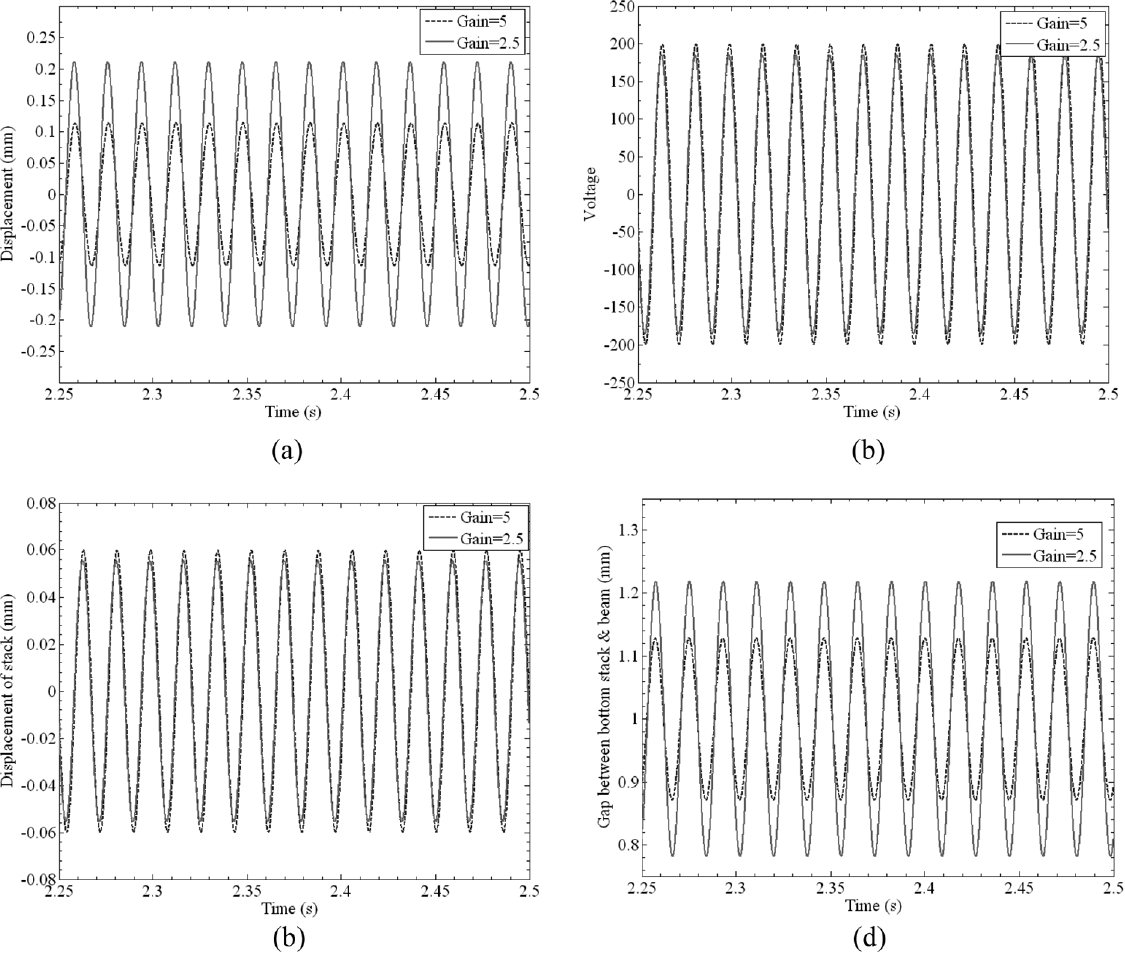
Fig. 13. (a) Displacement of the beam, (b) control voltage in the stack, (c) displacement of the bottom stack and (d) gap between the bottom actuator and the beam for a pure harmonic exciation of amplitude 4 N close to the fi rst resonant frequency. 327 Hz. Both the root loci start from little left of the imaginary axis because of the damping of the material of the beam. This gap is very small for the fi rst mode but can be observed on a closer examination. If the beam is approximated as a SDOF system having only the fi rst mode, the real part of Fig. 8(a) equals the product of damping ratio ξ and natural frequency Ω n . The imaginary part represents the damped natural frequency Ω d = Ω n